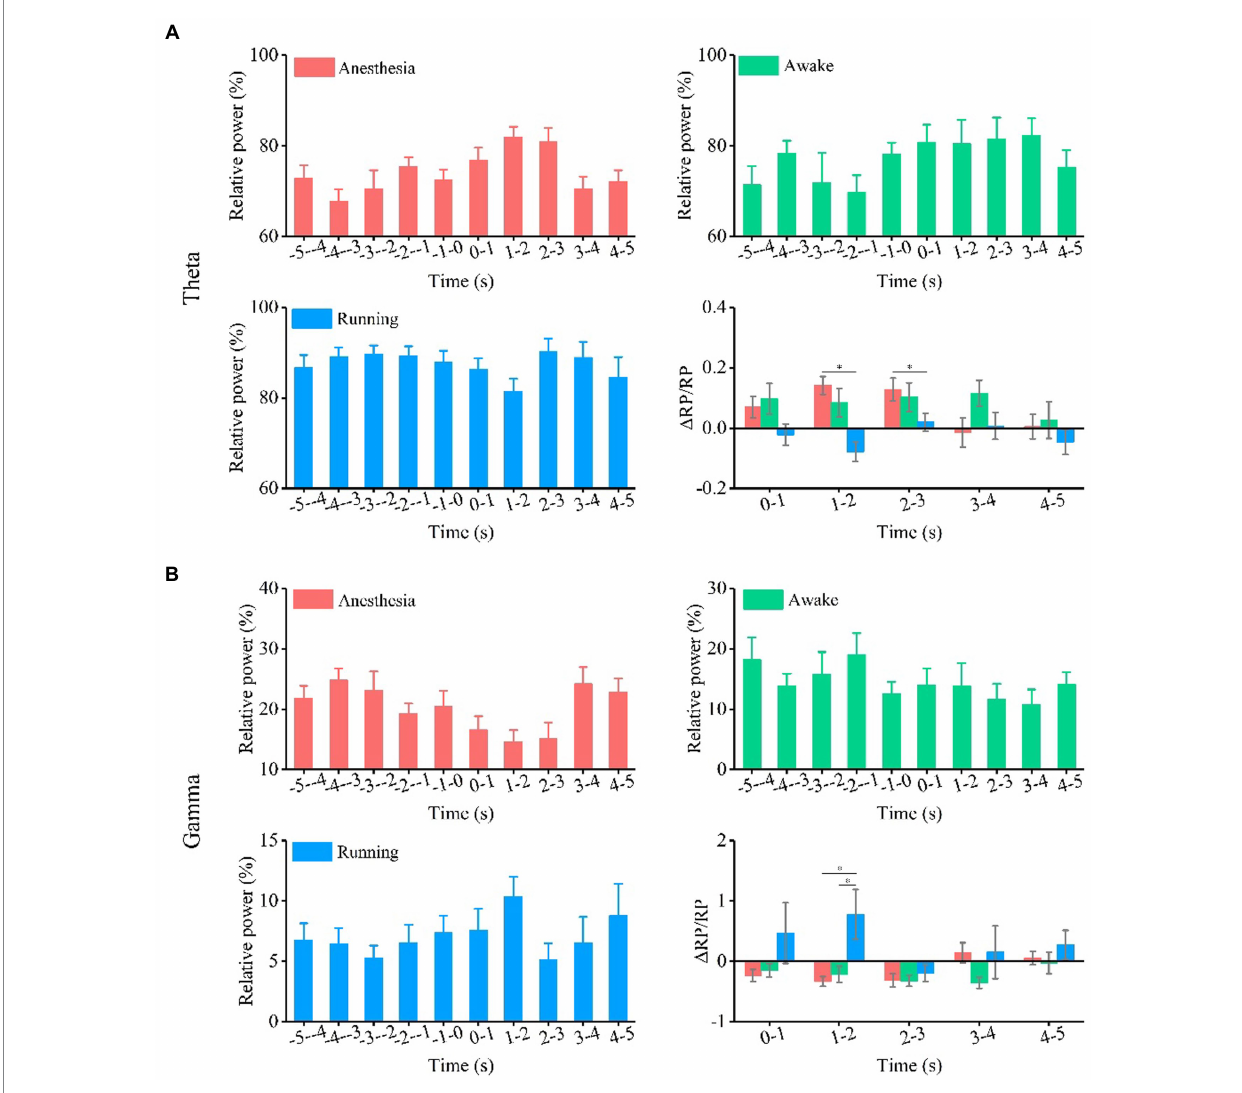
FIGURE 4 Relative power and relative change of relative power of theta and gamma oscillation under the anesthesia, awake state, and running state. (A) Theta oscillation. (B) Gamma oscillation. ( N = 7 for each state, mean ± SEM, * p < 0.05, Kruskal–Wallis test with post-hoc pairwise